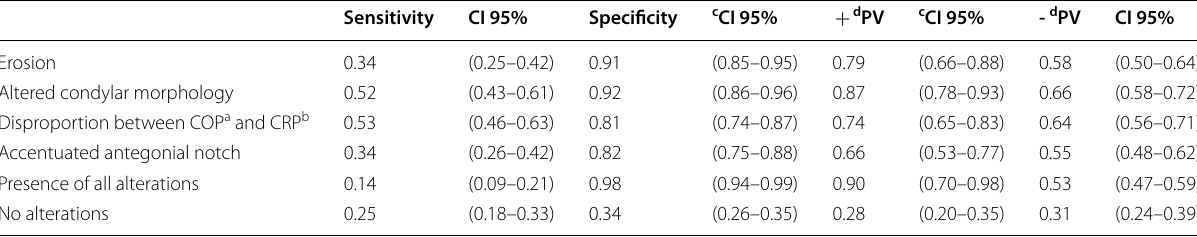
Table 3 Sensitivity, specificity, positive predictive value and negative predictive value of radiographic changes in patients with juvenile idiopathic arthritis and control group